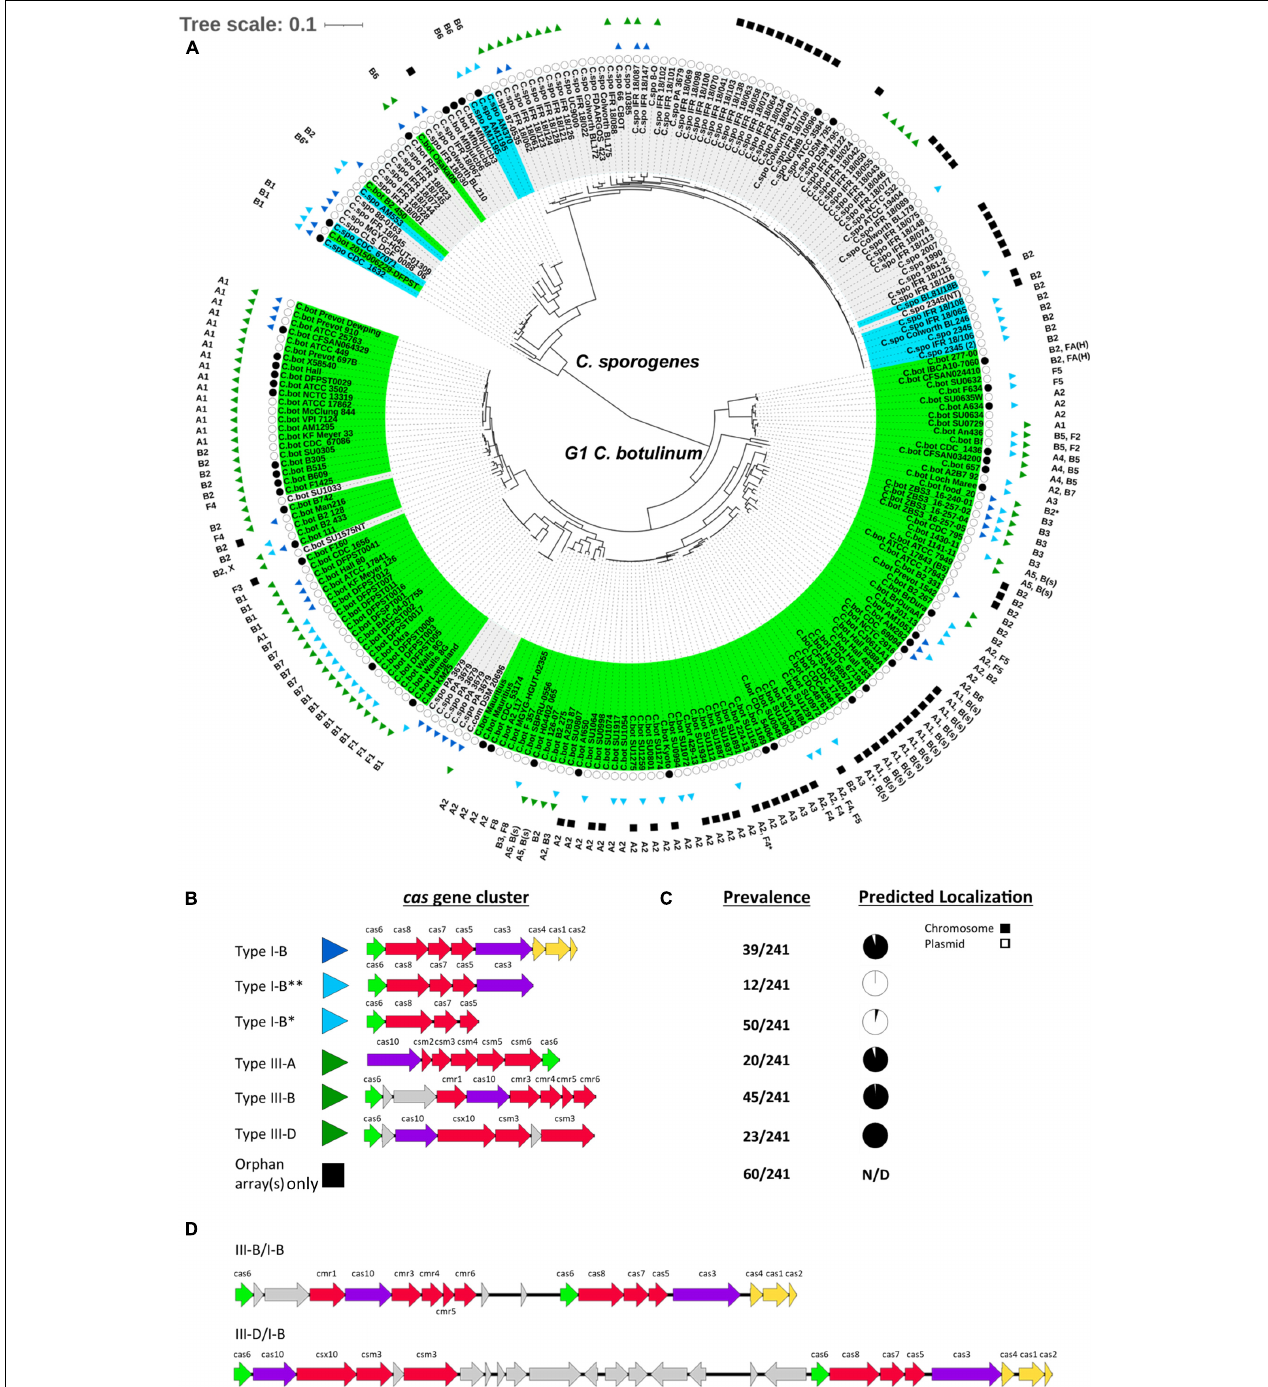
FIGURE 2 | CRISPR-Cas systems in group I C. botulinum and C. sporogenes . (A) A core genome SNP matrix phylogenetic tree of 241 G1 C. botulinum and C. sporogenes indicating two major clades predominantly demarcated by the respective species. Closed black circles indicate complete genomes ( n = 45). Cas gene clusters are represented by colored arrows and correspond to CRISPR-Cas system type in (B) . Solid black square indicates strains with predicted CRISPR arrays but no cas genes. Predicted BoNT serotype(s) are listed on the outermost band of the tree and strain names shaded by published species and toxin presence: bont (+)/G1 C. botulinum , bont (+)/ C. sporogenes , bont( − ). (B) Gene schematic of the major cas gene clusters identified in G1 C. botulinum and C. sporogenes . (C) Prevalence of each CRISPR-Cas system type/subtype throughout the assemblies included in the study dataset and distribution by predicted plasmid or chromosomal localization for each contig carrying the CRISPR-Cas system subtype. (D) Potential hybrid/coupled type I-B and type III-B or III-D CRISPR-Cas systems generally occur in strains in possession of both.